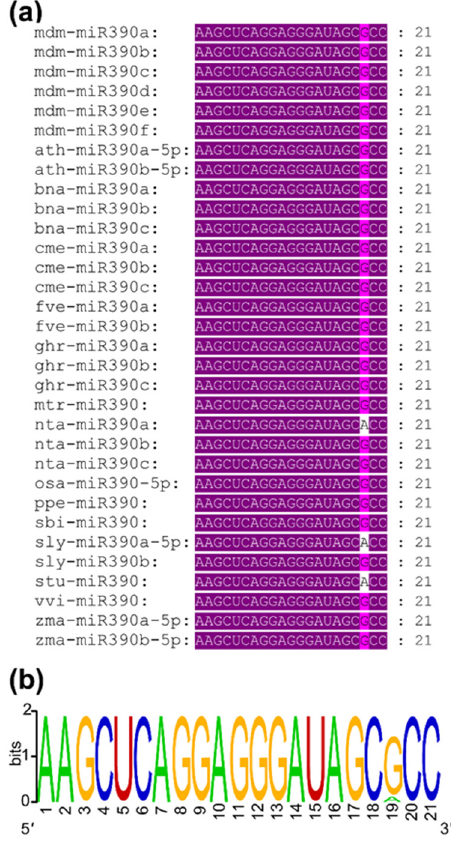
Figure 2. Mature sequence analysis of miR390s. ( a ) Sequence alignment of mdm-miR390s with other homologous sequences. ( b ) Conserved bases of miR390 mature sequences in fifteen species.